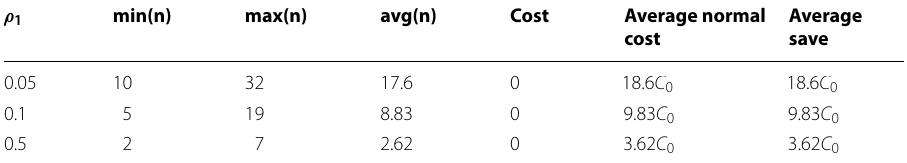
Table 3 The results of the third group of experiments ρ 1 min(n) max(n) avg(n) Cost